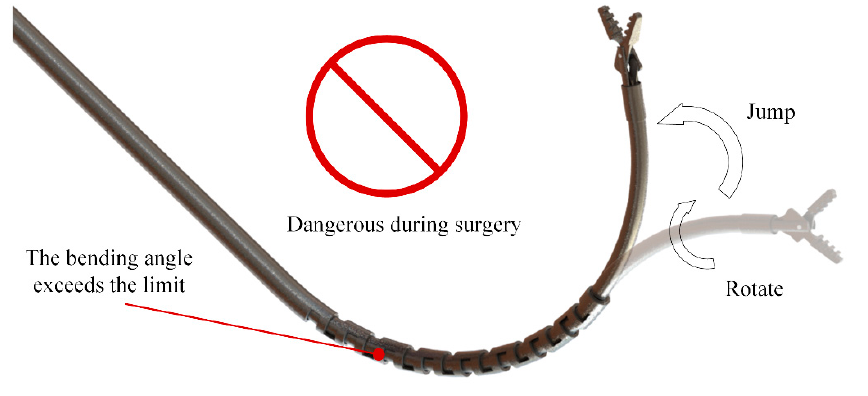
Figure 6. Stability issues of the